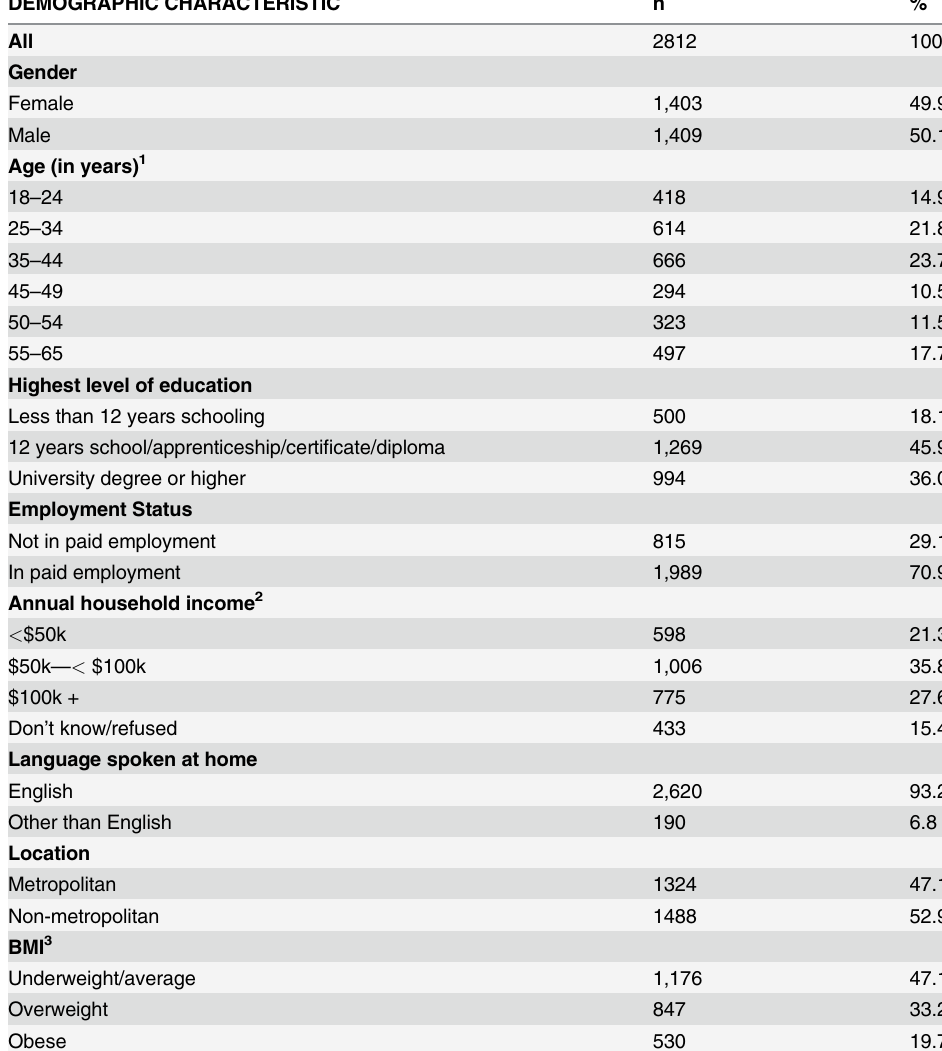
Table 1. Unweighted demographic characteristics and (weighted) distribution of BMI in post-cam- paign sample. DEMOGRAPHIC